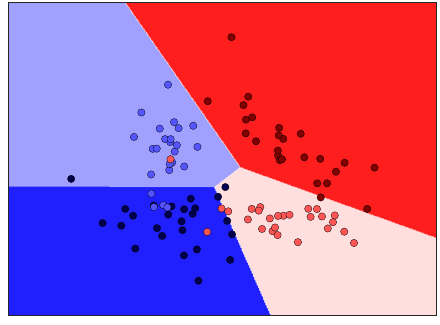
Figure A2. Multi-class SVM for four classes. The hyperplanes (lines) in the 2-D space clearly separate the four distinct classes with acceptable misclassification rates. A smooth approximation can be made using a four-class softmax